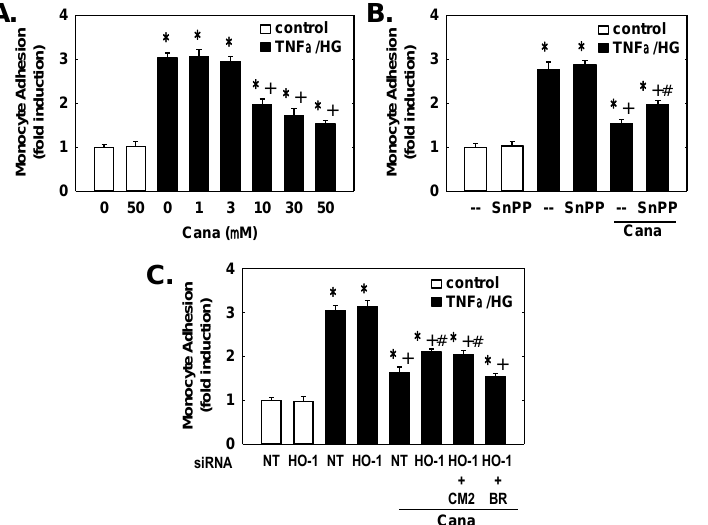
Figure 3. HO-1 contributes to the anti-inflammatory action of canagliflozin (Cana). ( A ) Effect of Cana (0–50 µ M) on monocyte adhesion following treatment of ECs with TNF α (10 ng/mL) and a high concentration of glucose (HG; 25 mM) for 24 h. ( B ) Effect of HO-1 inhibition on Cana-mediated